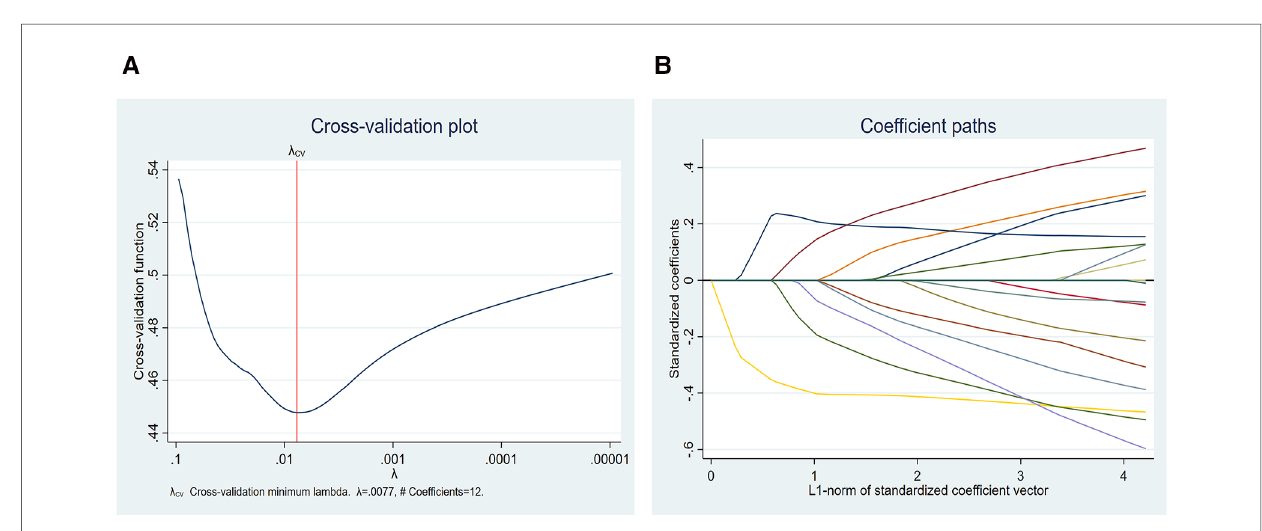
FIGURE 3 LASSO regression showed log ( λ )=0.0077 when the model error was minimized, and 12 variables were selected for further logistic regression analysis.